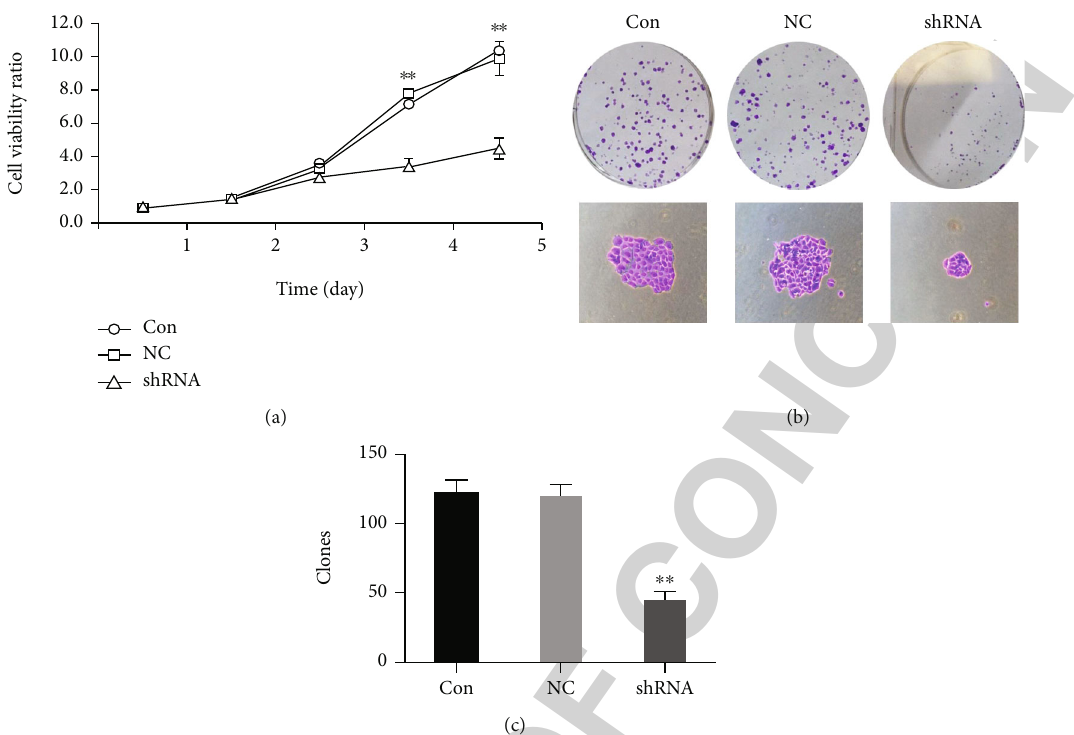
Figure 3: (a) MTT assay manifested that Hep-G2 cell proliferation was inhibited by LOXL1-AS1-speci fi c shRNA expression. The value was expressed as the mean ± SD of three independent experiments ( ∗∗ meant P < 0 : 01 ). (b, c) Hep-G2 cells infected with Lv-shLOXL1-AS1 or Lv- NC were seeded in 6-well plates and measured 14 days after culturing. (b) Representative Giemsa staining pictures of the colonies by Hep-G2 cells 14 days after plating. (c) The number of Hep-G2 cell colonies after seeding for 14 days was counted (graph revealed mean ± SD , ∗∗ meant P < 0 : 01 ).